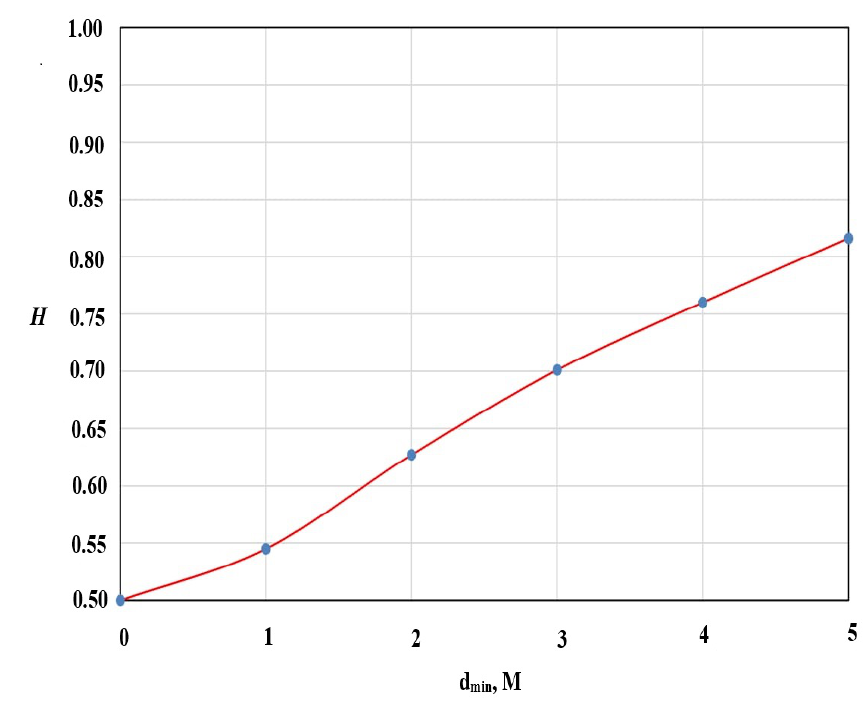
Figure 9. Dependence of the Hurst parameter on the value of the minimum offset d min